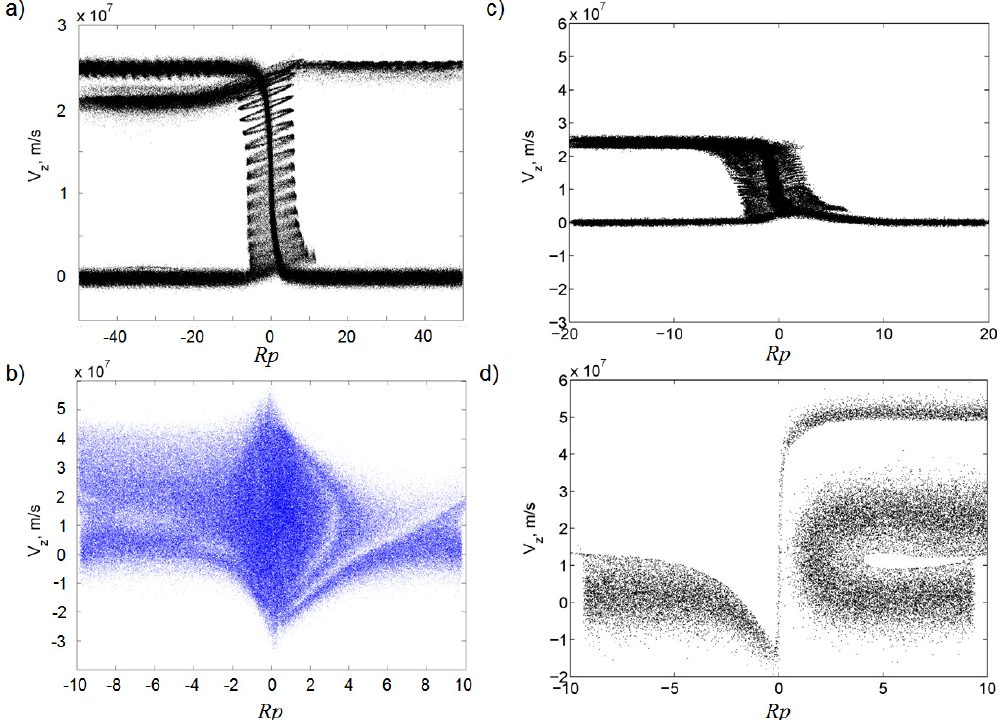
Figure 8. Particle distributions simulated with PIC for the magnetic topology (low magnetic field, low plasma density): (a) distribution of protons (transit and bounced) for a weak guiding field ( B y = 0 . 01 B 0 , B 0 = 10 − 8 T), showing protons ejected to both sides of the midplane; (b) distribution of electrons for the same weak guiding field as in (a) , forming an electron cloud about the midplane (transit electrons), with bounced electrons ejected to the same side as protons in (a) ; (c) distribution of protons for a strong guiding field ( B y = 0 . 5 B 0 , B 0 = 10 − 8 T) with ejection to the negative semiplane ( X < 0) (full separation from electrons); (d) distribution of electrons for the same guiding field as in (c) , with electrons being ejected to the positive semiplane ( X > 0) as a high-energy stream (transit electrons) and as a shoe-like low-energy flux (bounced